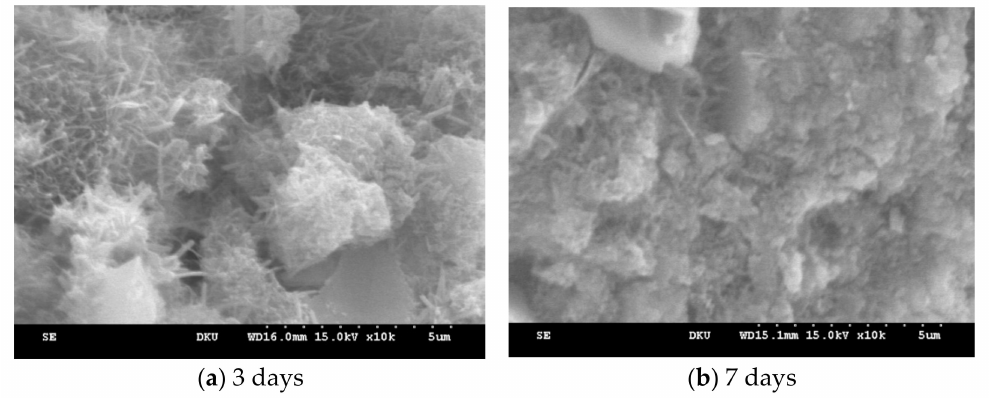
Figure 11. Microstructure characteristics (insulated gang